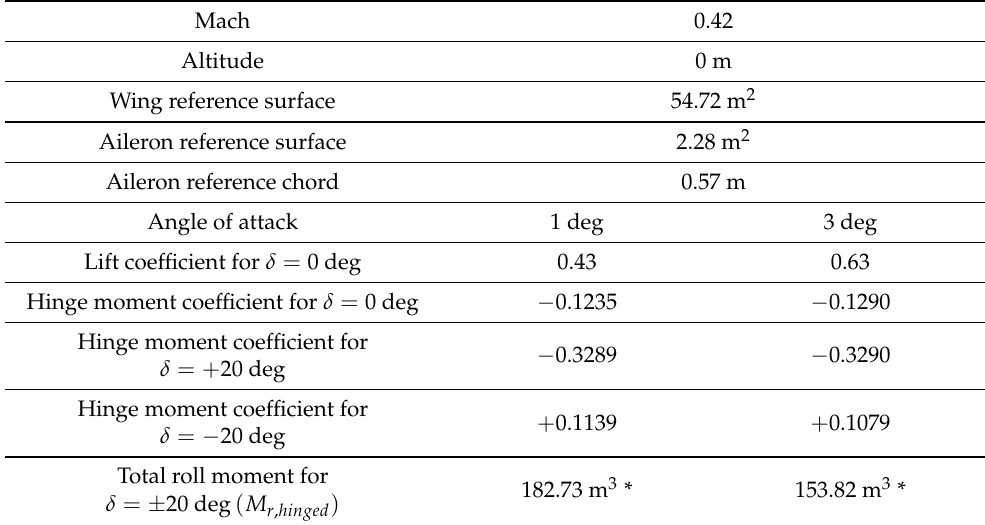
Table 1. Reference design